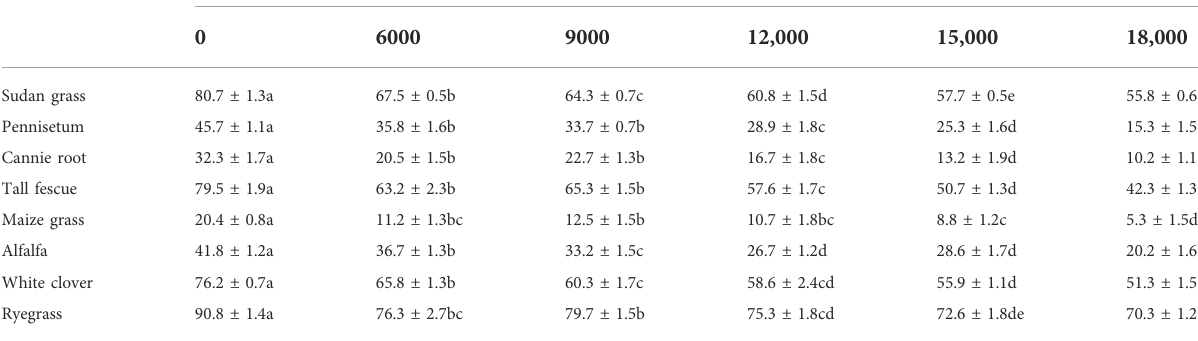
TABLE 5 Germination rate of eight plant seeds at different petroleum hydrocarbons concentrations (%).